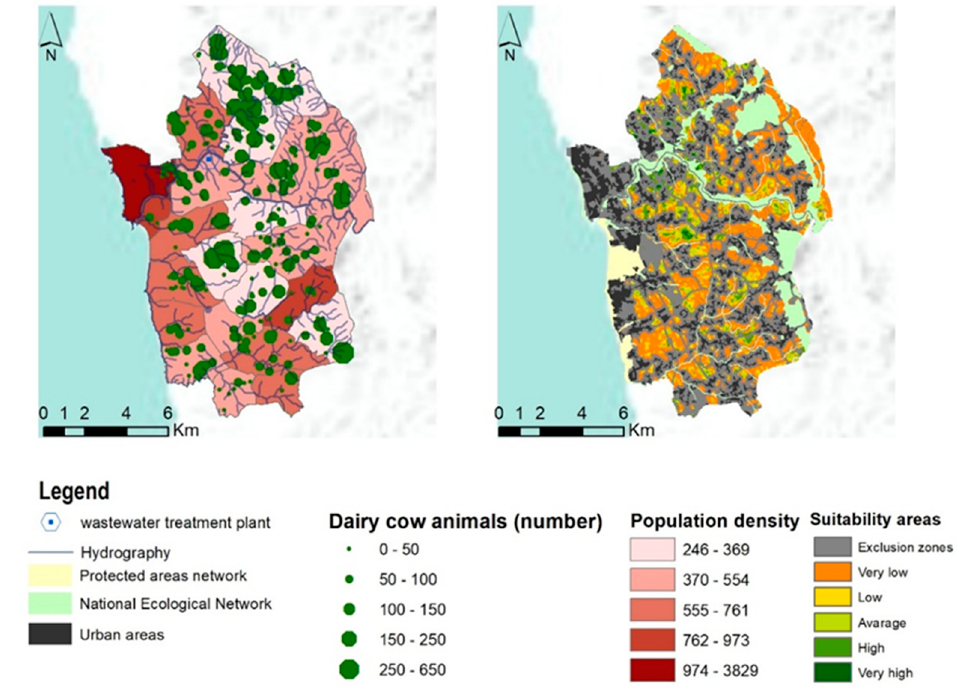
Figure 4. Population density (inhabitants km − 2 , dairy cattle farms (number) and biogas production facility location suitability.